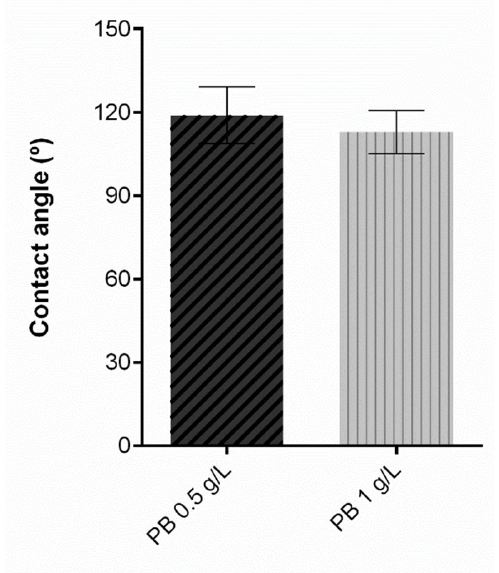
Figure 7. Contact angle measurement of polyester after coating with Prussian blue (PB) formulations at different concentrations (0.5 g/L, 1 g/L and 2 g/L), (n = 10, ± SD).